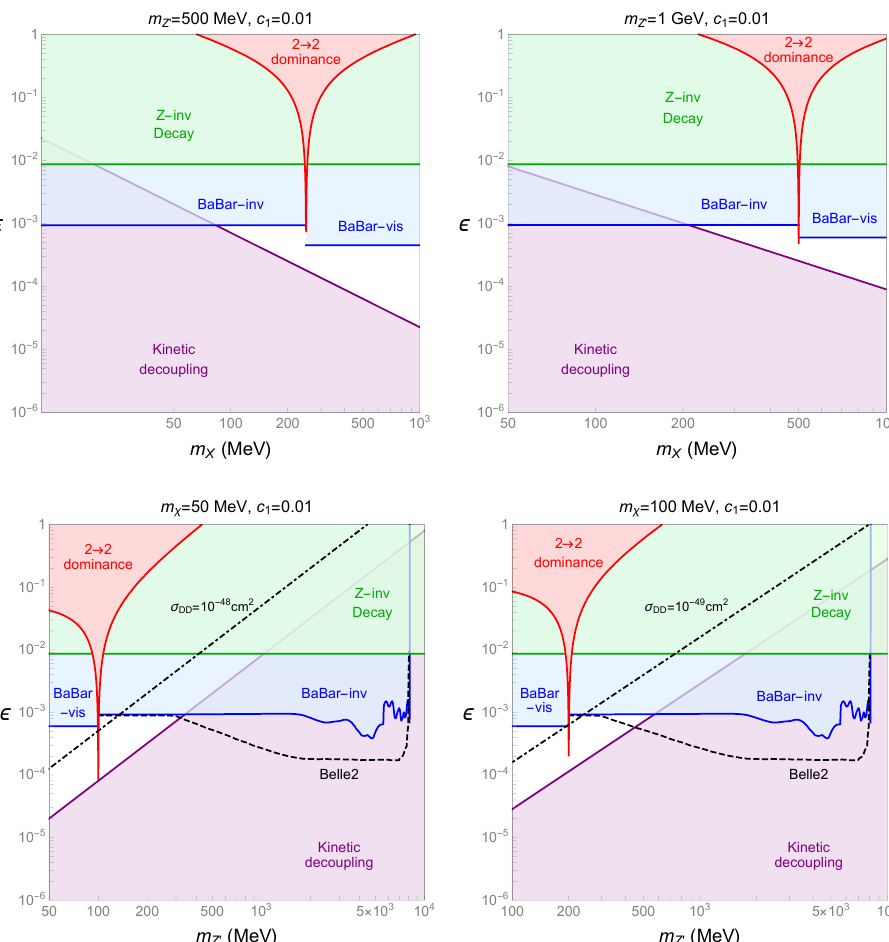
Figure 5 . Allowed parameter space for vector SIMPs with a Z 0 portal. Top: parameter space of m X vs. " for c 1 = 0 : 01, for m Z 0 = 500 MeV ( left ) and 1 GeV ( right ). Bottom: parameter space of m Z 0 vs. " for c 1 = 0 : 01, for m X = 50 MeV ( left ) and 100 MeV ( right ). Here, we took N f (cid:11) Z 0 = 1 in eq. (2.18) for the Z -boson invisible decay bound. In all panels: the purple region indicates where the kinetic equilibrium condition fails; the green region is excluded by the Z -boson invisible decay [65]; and the red region is where the 2 ! 2 annihilation becomes dominant. BaBar searches for monophotons with MET [66] and with dileptons [67] exclude the blue region. The projected Belle-II reach for monophoton+MET [68] is depicted in dashed blue curve. Contours for DM-electron scattering cross section with (cid:27) DD = 10 (cid:0) 48 (49) cm 2 are also shown in dot-dashed lines on the left (right)